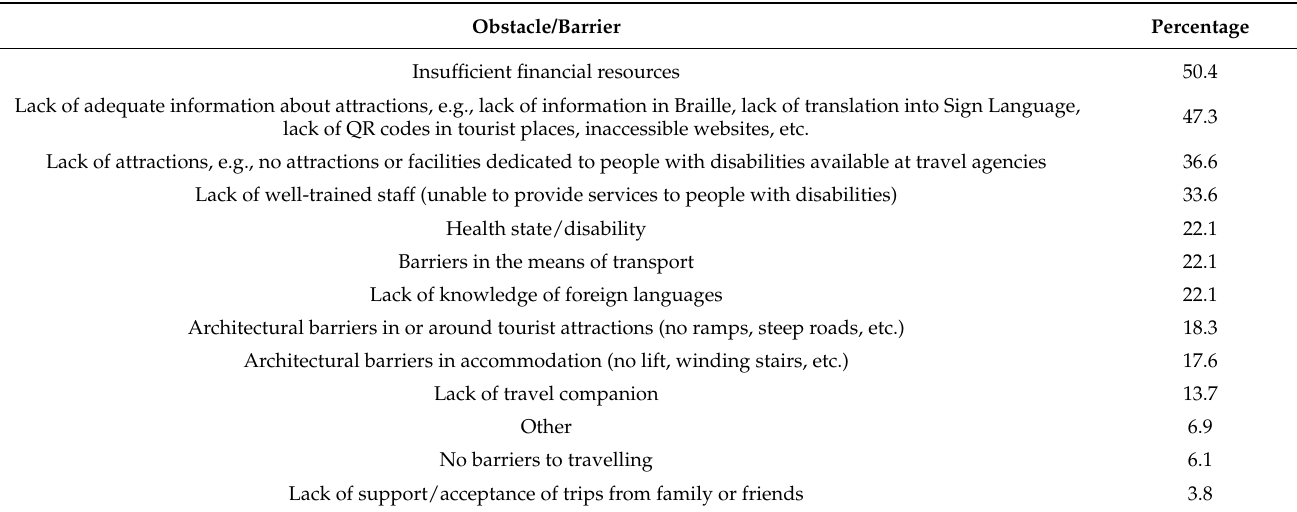
Table 3. The main obstacles or barriers faced when travelling. Obstacle/Barrier Percentage Insufficient financial resources